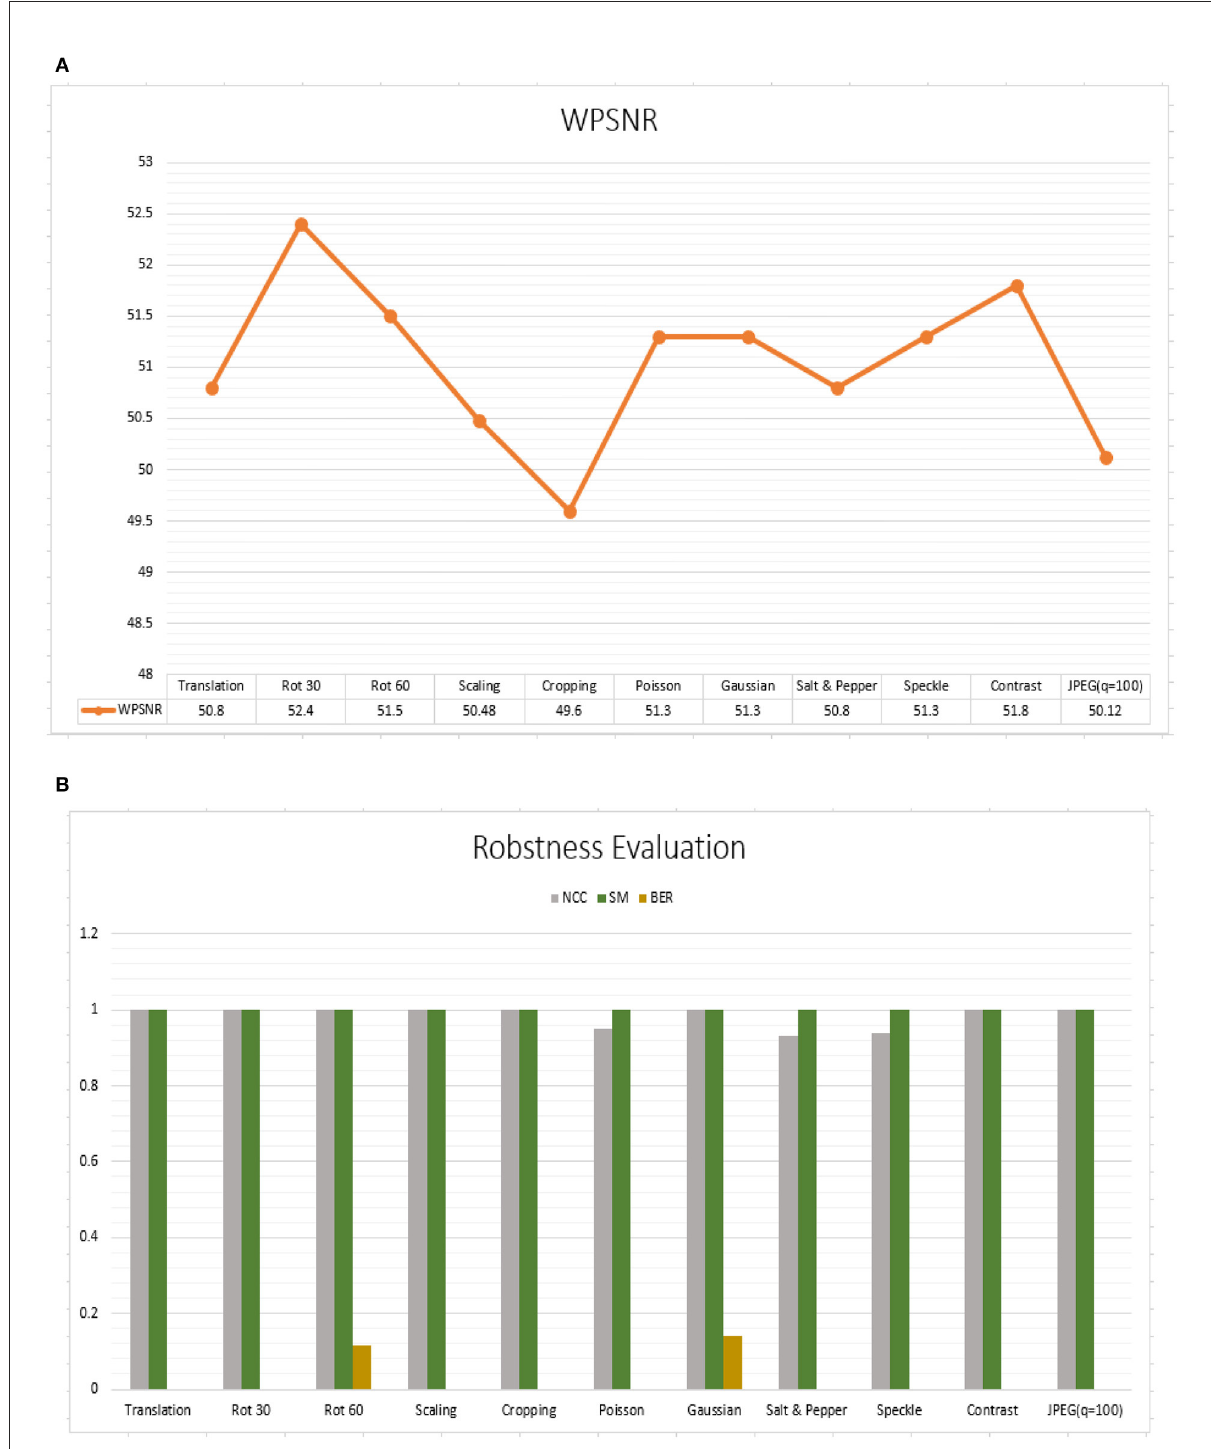
FIGURE12 (A) Performance outcome of robustness (WPSNR), (B) Performance outcome of NCC (Normalized Cross-Correlation), SM (Similarity Measurement), BER (Bit Error